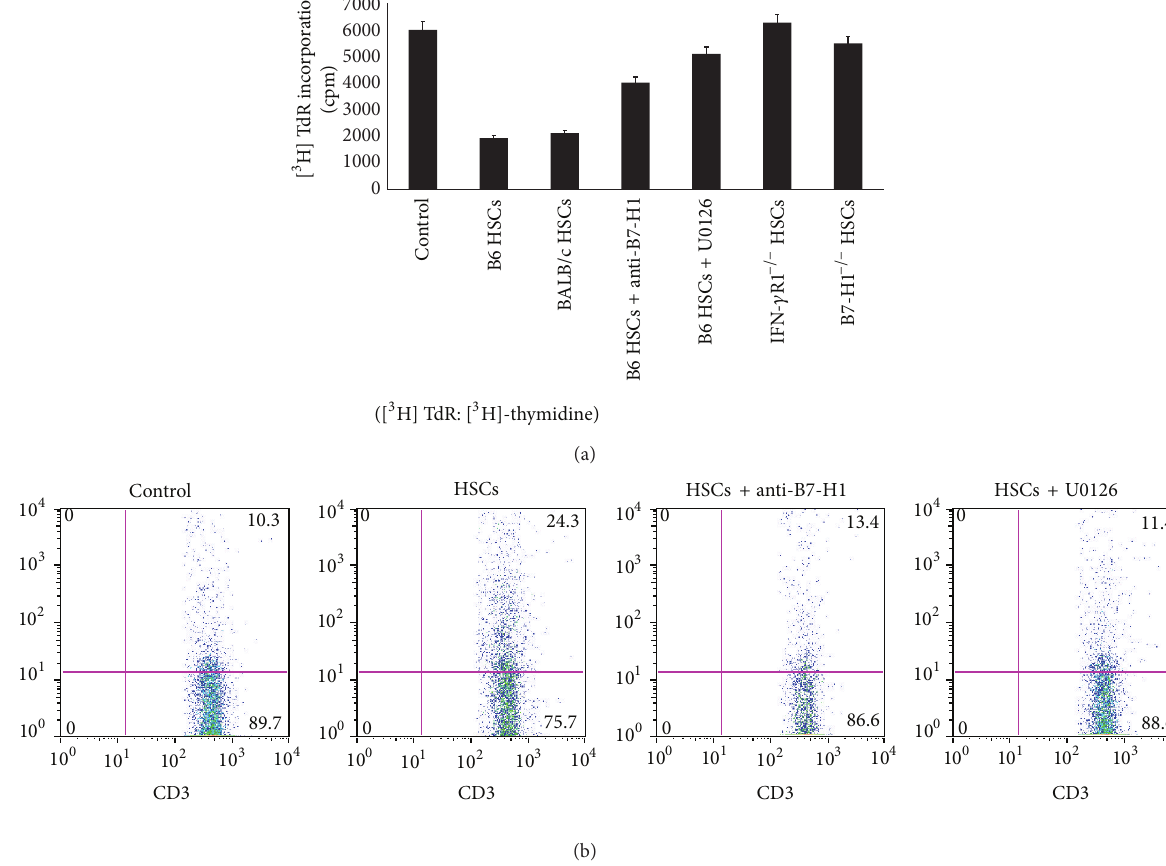
Figure 3: T-cell inhibition by HSCs. (a) B6, BALB/c, IFN- 𝛾 R1 KO, or B7-H1 KO HSCs cultured in uncoated plastics for 7 days were 𝛾 - irradiated (50Gy) and added at the beginning of an MLR culture in which splenic T cells (2 × 10 5 ) from BALB/c mice, and irradiated (20Gy) B6 DCs were cultured at a final T-cell/DC/HSC ratio of 20: 2:1 for 3 days. In some groups, irradiated HSCs pre-incubated with 100 𝜇 M U0126 or anti-B7-H1. Controls were without HSCs. The data are representative of three separate experiments. (b) Cells following cultures for 2 or 3 days were double stained with FITC-anti-CD3 and PE-anti-Annexin V for flow analysis. The data demonstrated Annexin V expression in CD3+ populations. In some groups, irradiated HSCs pre-incubated with 100 𝜇 M U0126 or anti-B7-H1. Controls were without HSCs. The data are representative of three separate